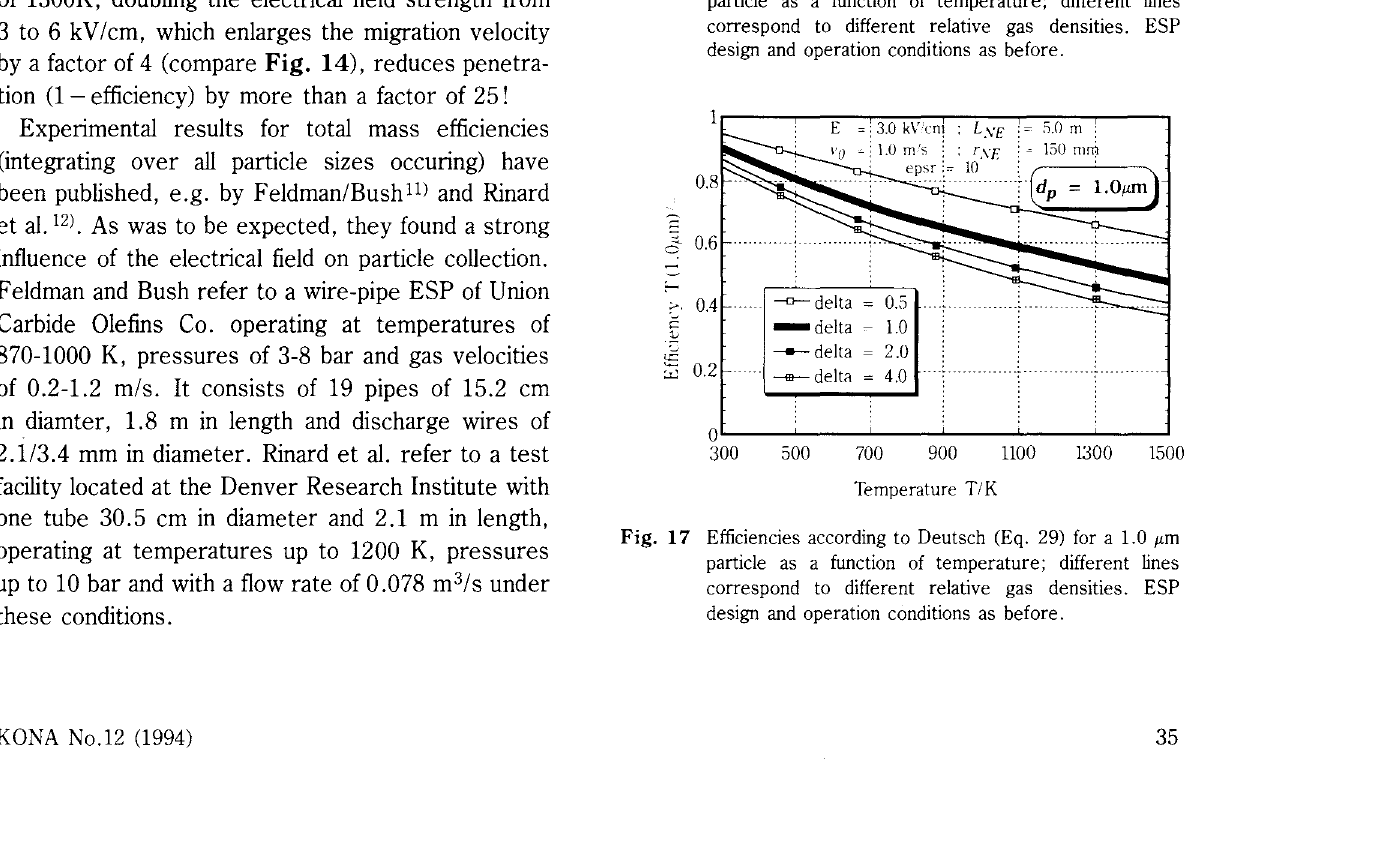
·~ 'i.O m . . : o l'iO nm)